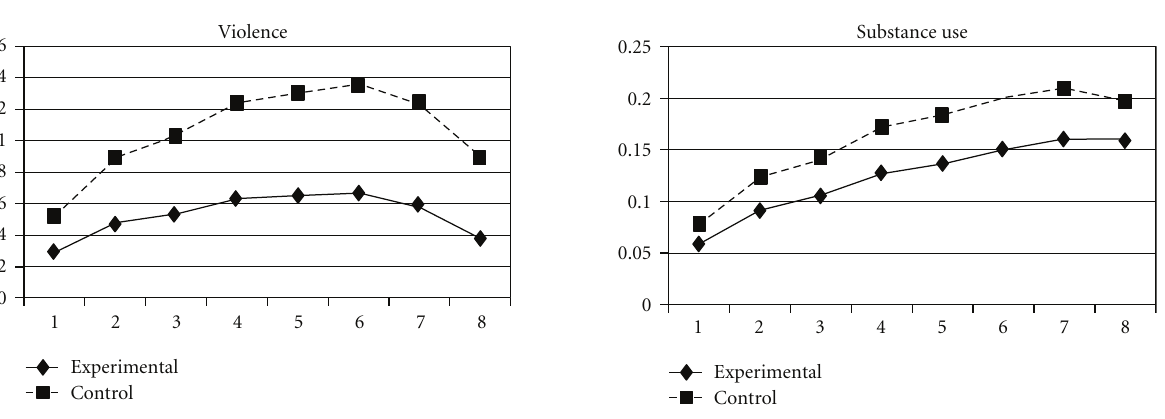
Figure 3: Growth trajectories of the experimental group (all par- ticipants) and control group using the item score of violence as the outcome indicator.